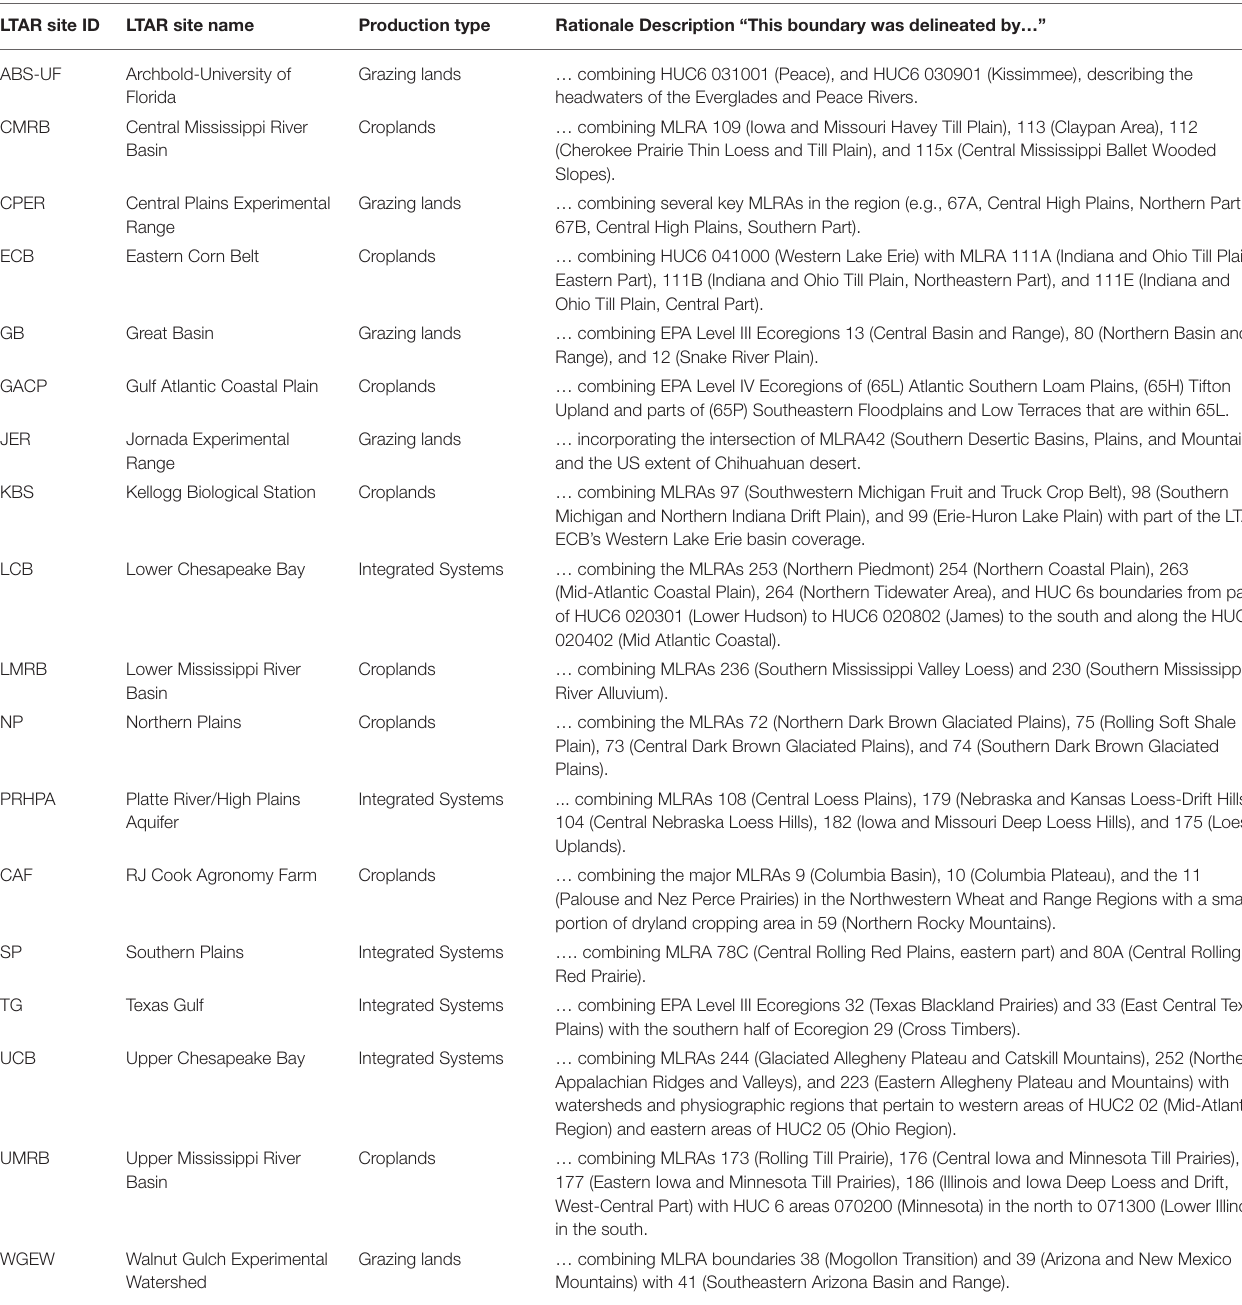
TABLE 1 | Rationale for “production boundary” delineation of the 18 Long-Term Agroecosystem Research (LTAR) sites. LTAR site